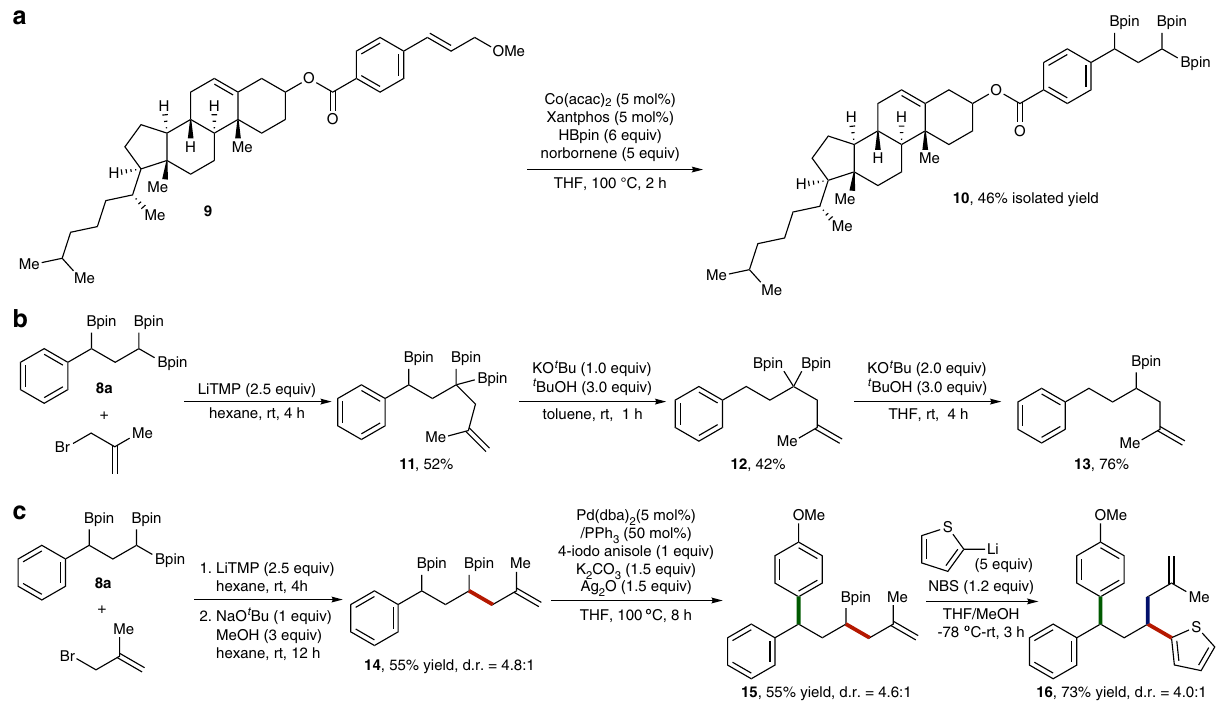
Fig. 3 Synthetic applications of the deoxygenative triborylation method. a Triborylation of a cholesterol derived allylic ether. b Allylation of 8a and sequential deborylation reactions. c Stepwise functionalization of 1,1,3-triborylalkane 8a with sequential three new carbon-carbon bond-forming